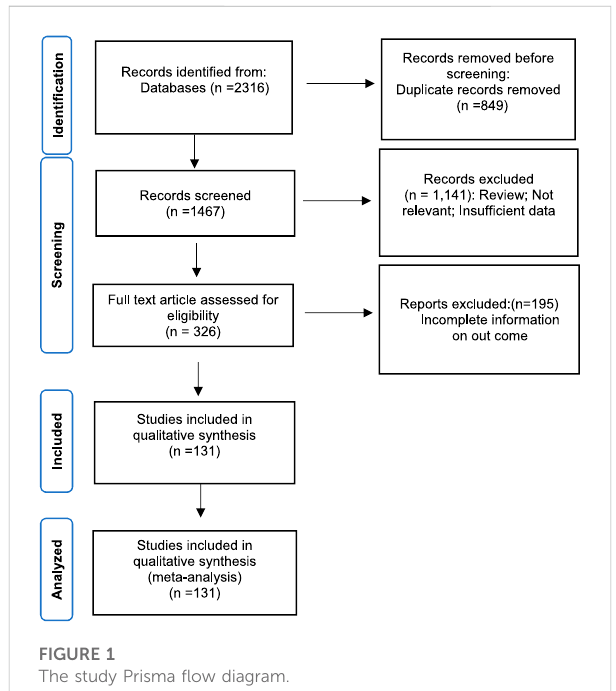
The study Prisma fl ow